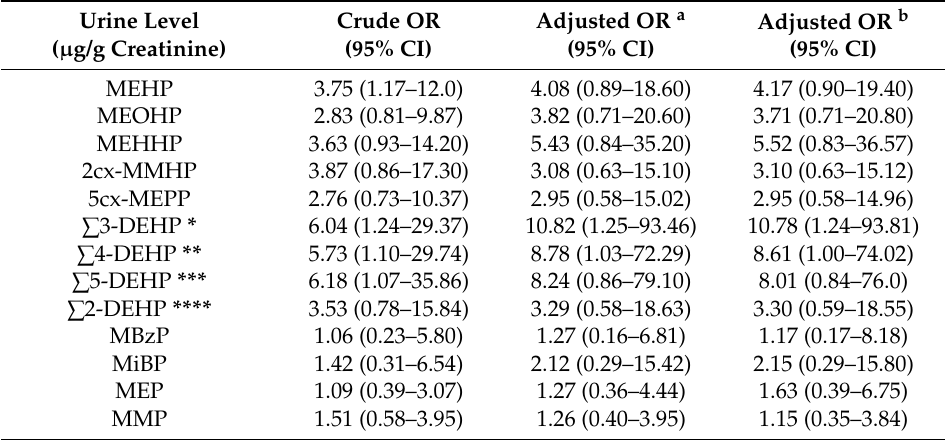
Table 4. Odds ratio and 95% confidence interval (CI) for the association between leiomyoma and log transformed creatinine-adjusted urinary phthalate